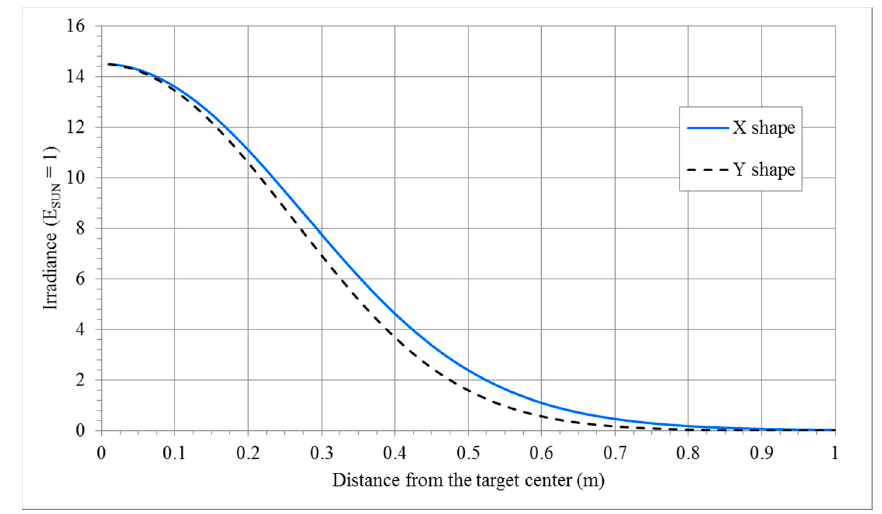
Figure 13. Target irradiance for a 5 × 5 heliostat field with row distance 4 m and column distance 10 m.